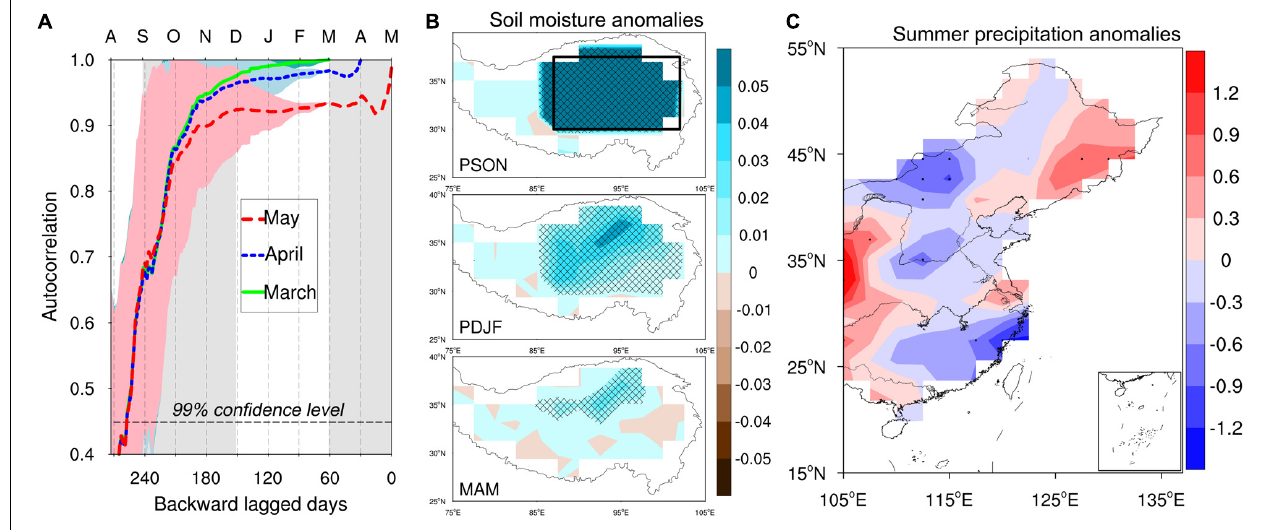
FIGURE 5 | Seasonal persistence of soil moisture anomalies and its impacts on summer precipitation in Eastern China (EC) (Yang and Wang, 2019a). (A) Soil moisture memory, which is defined as the lagged days when the autocorrelation of soil moisture does not pass significant test at 0.01. (B) Patterns of soil moisture anomalies during preceding autumn (PSON), preceding winter (PDJF), and spring (MAM), when soil moisture is increased over the eastern region of the Tibetan Plateau (rectangular box). (C) Corresponding pattern of summer precipitation anomalies (mm/day) in EC to the soil moisture anomalies in panel (B)